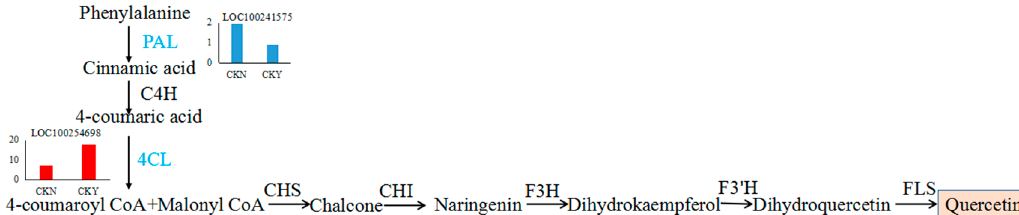
Figure 10. Quercetin biosynthesis pathway. Each histogram displays the expression levels of each gene (FPKM value). The histograms in blue and red represent the down-regulated and up-regulated structural genes, respectively. Chalcone synthase, CHS . Chalcone isomerase, CHI . Flavanone 3-hydroxylase, F3H . Flavanone 3 ′ -hydroxylase, F3 ′ H . Flavonol synthase, FLS .